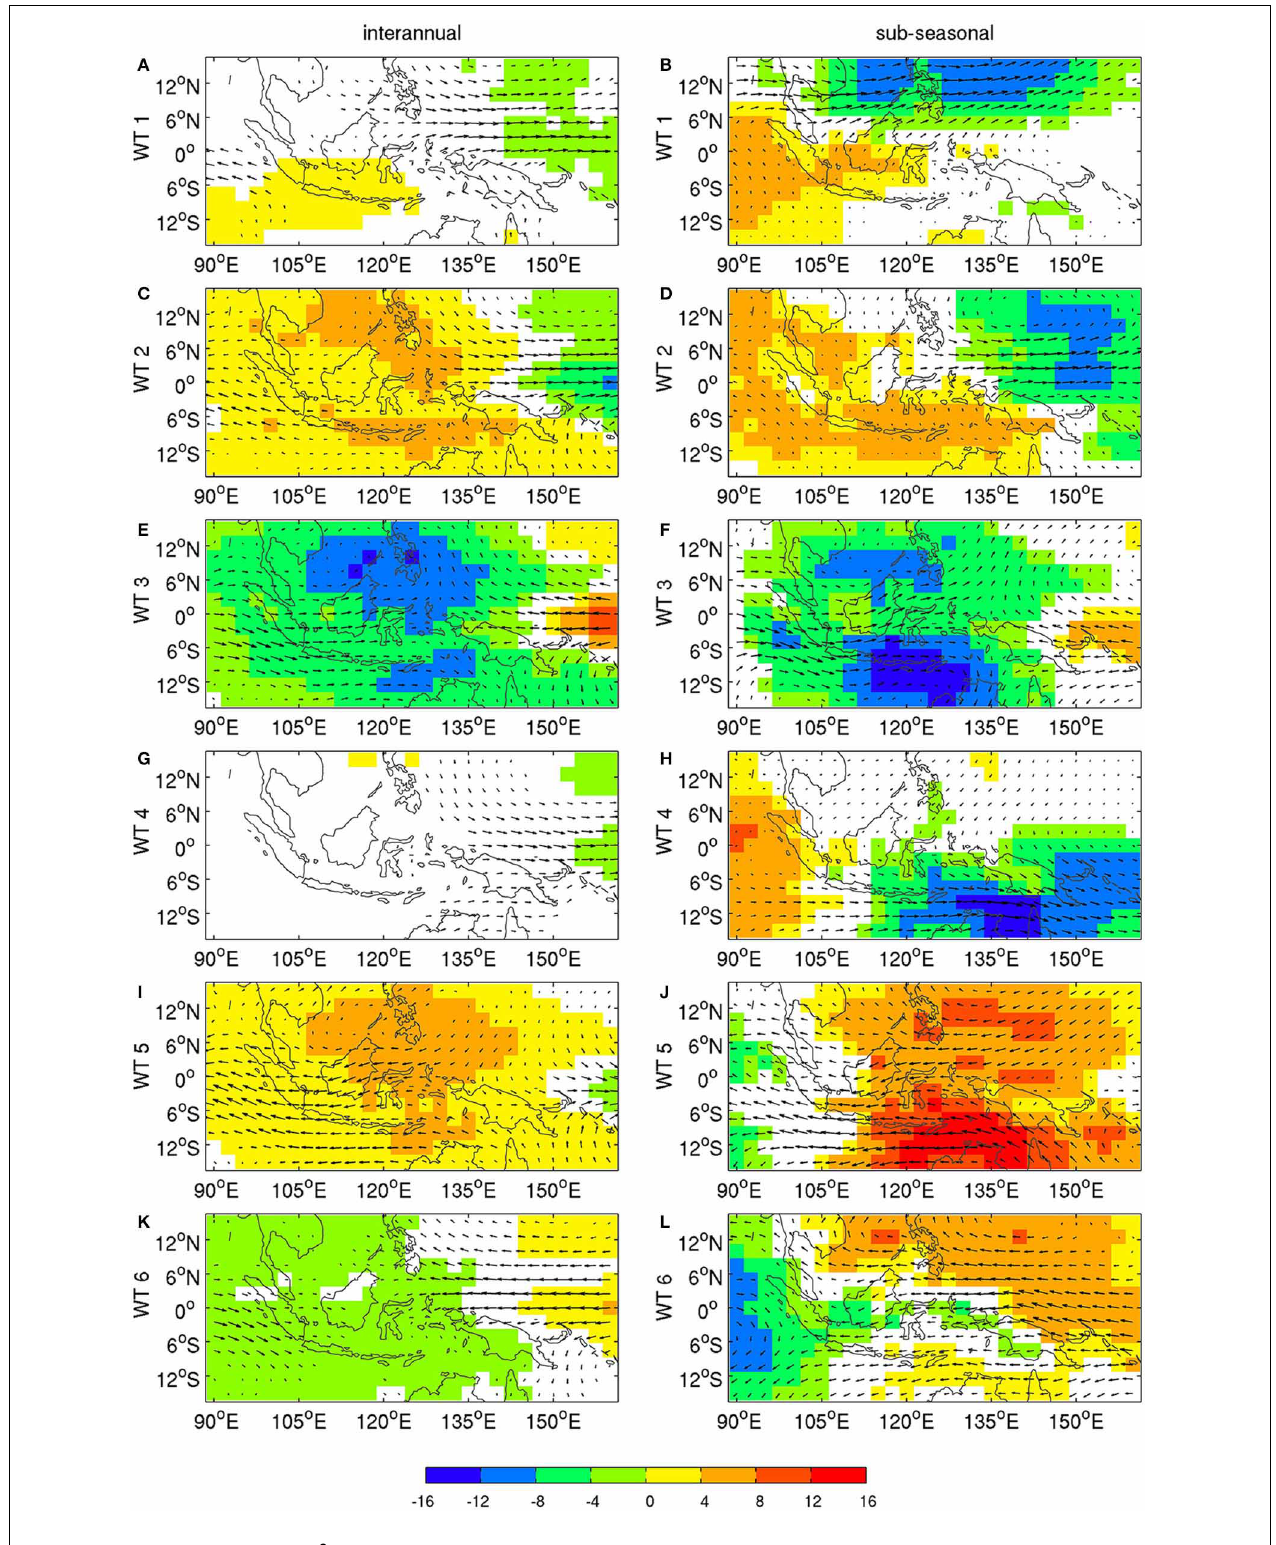
sequences amongst the 34 years to account for the mean seasonal cycle, i.e., taken at the same stage of the cycle, and shown as color (OLR) and vectors (850-hPa wind) only when OLR, zonal or meridional components of the wind are above the two-sided 95% level of significance according to random